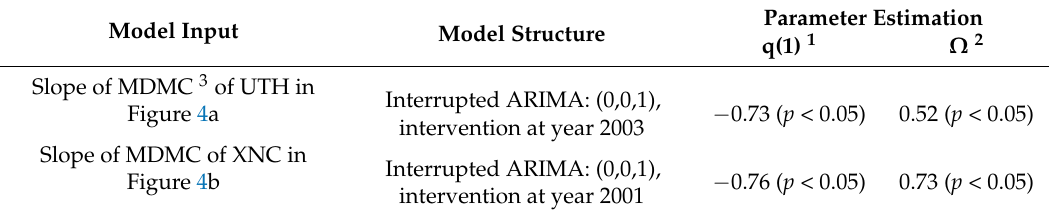
Figure 4. Double mass curve of accumulated annual streamflow ( Q a ) and accumulated annual effective precipitation ( P ae ) for: UTH ( a ); and XNC ( b ). Table 4. Interrupted ARIMA models for slopes of MDMC in Figure 4.